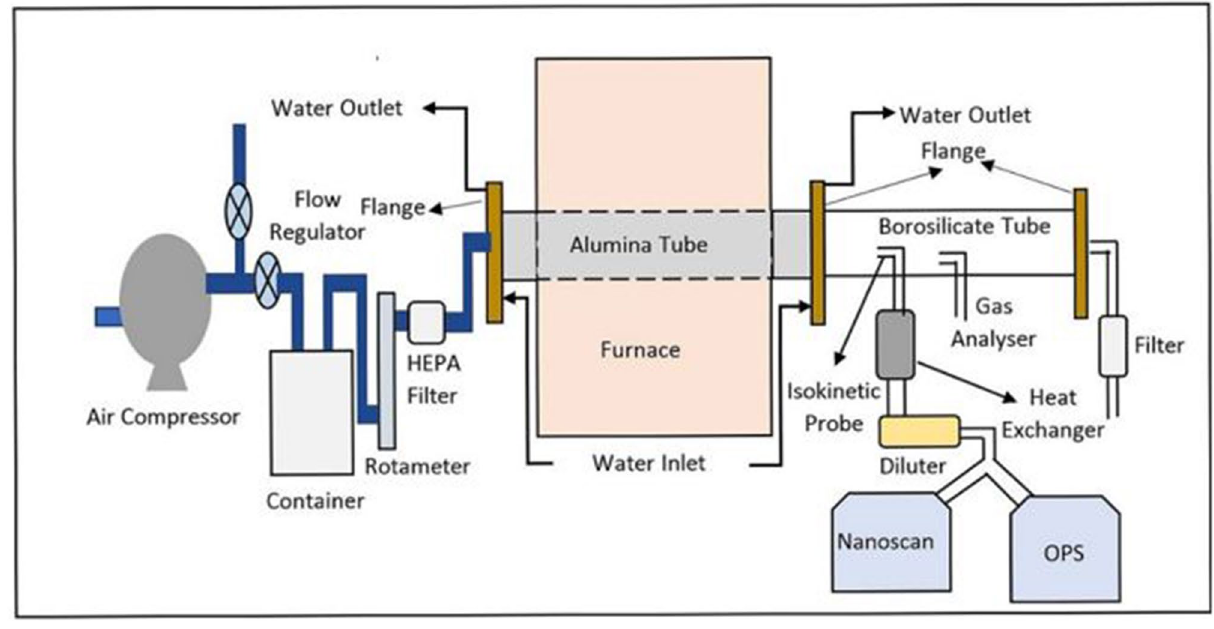
Figure 1. Schematic diagram of the experimental setup 46